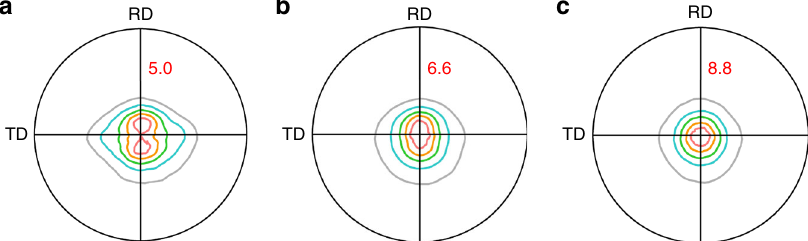
Fig. 4 Texture of the studied Mg alloys. Pole fi gures of basal (00.1) planes showing the texture of TRC-AZMX3110 ( a ), IC-AZMX3110 ( b ), and IC-AZX310 ( c ). The numbers in red color indicate the maximum texture intensity. While IC-AZMX3110 and IC-AZX310 exhibit a typical basal texture, the texture of TRC-AZMX3110 is characterized by a broadening of basal poles along the transverse direction (TD) and a splitting of basal poles toward the rolling direction (RD) from the normal direction (ND) of the sheet. In addition, the maximum texture intensity of TRC-AZMX3110 is lower than those of